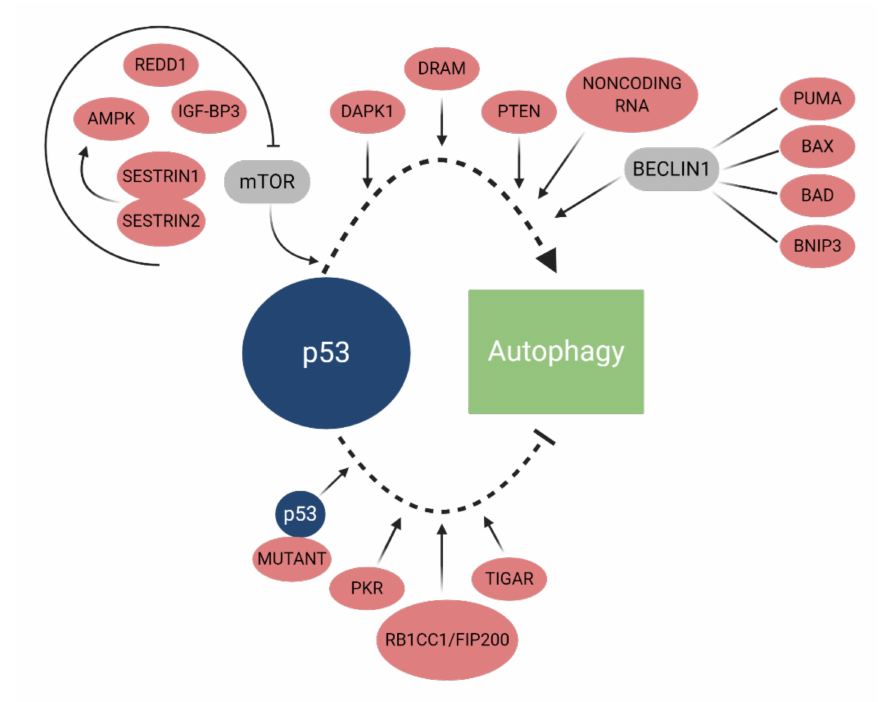
Figure 4. Regulation of autophagy by p53